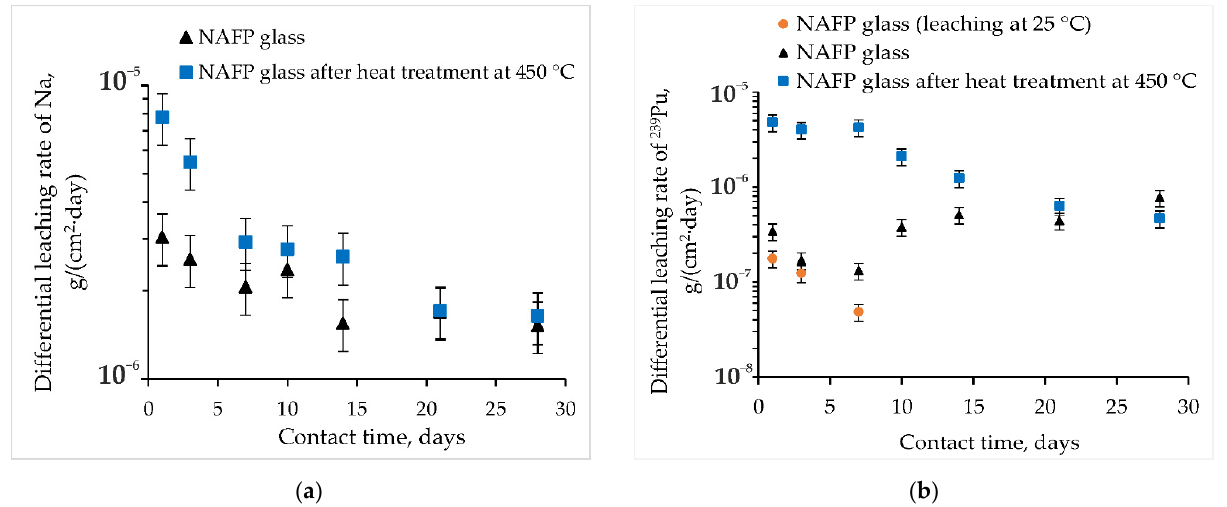
Figure 8. Kinetic curve of the leaching rate of ( a ) sodium and ( b ) plutonium from NAFP glass.